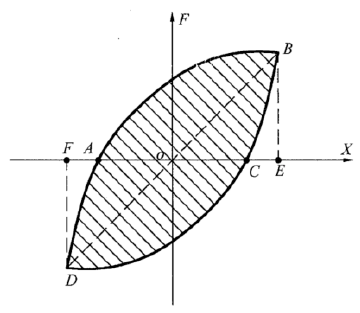
Figure 9. Energy dissipation computation.